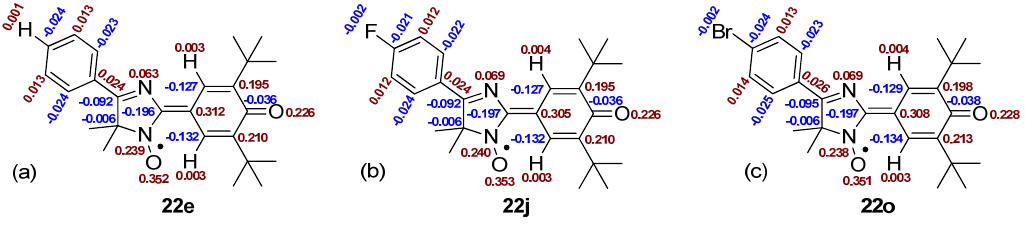
Figure 4. Mulliken atomic spin populations for ( a ) 22e , ( b ) 22j , ( c ) 22o calculated at the UB3LYP/6-31G(d) level of theory.